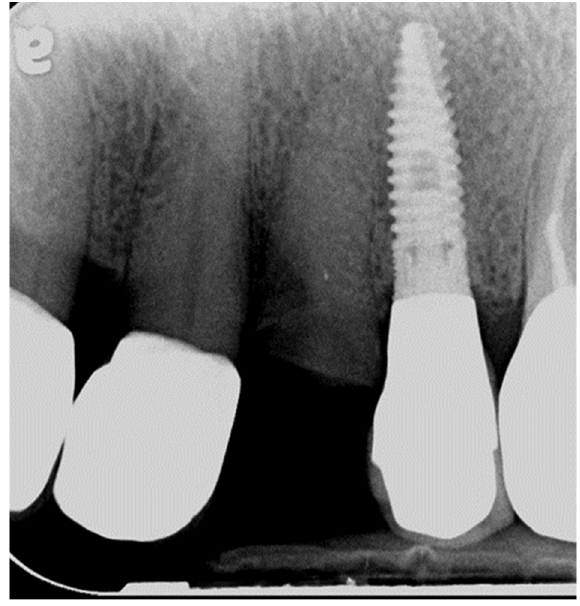
Figure 2. Patient 2—fractured first premolar . Patient 9 had a non-vital fractured canine after 5 years of function. Neither patient wore an occlusal splint (Table 4). Table 4. Patients and observed absolute and relative failures per patient .